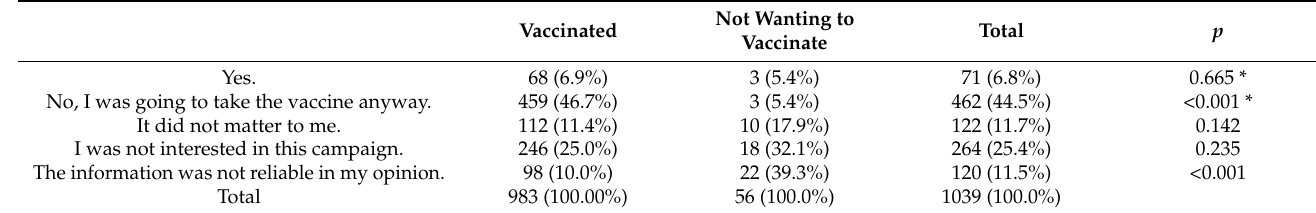
Table 5. Influence of the government campaign on the decision to vaccinate. Not Wanting to Vaccinated Total p Vaccinate Yes. 68 (6.9%) 3